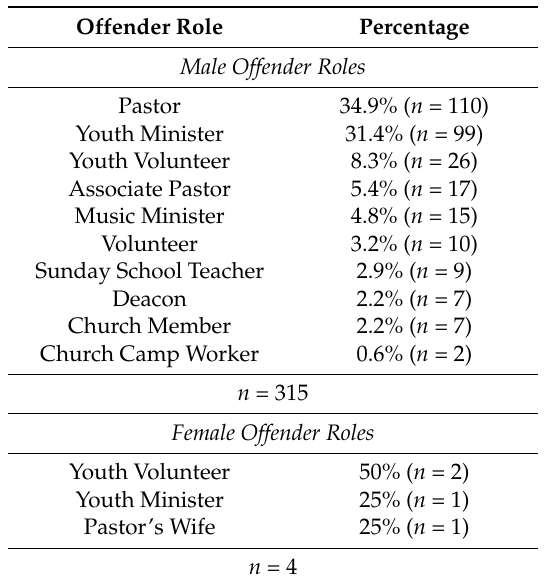
Table 2. Offender Role within the